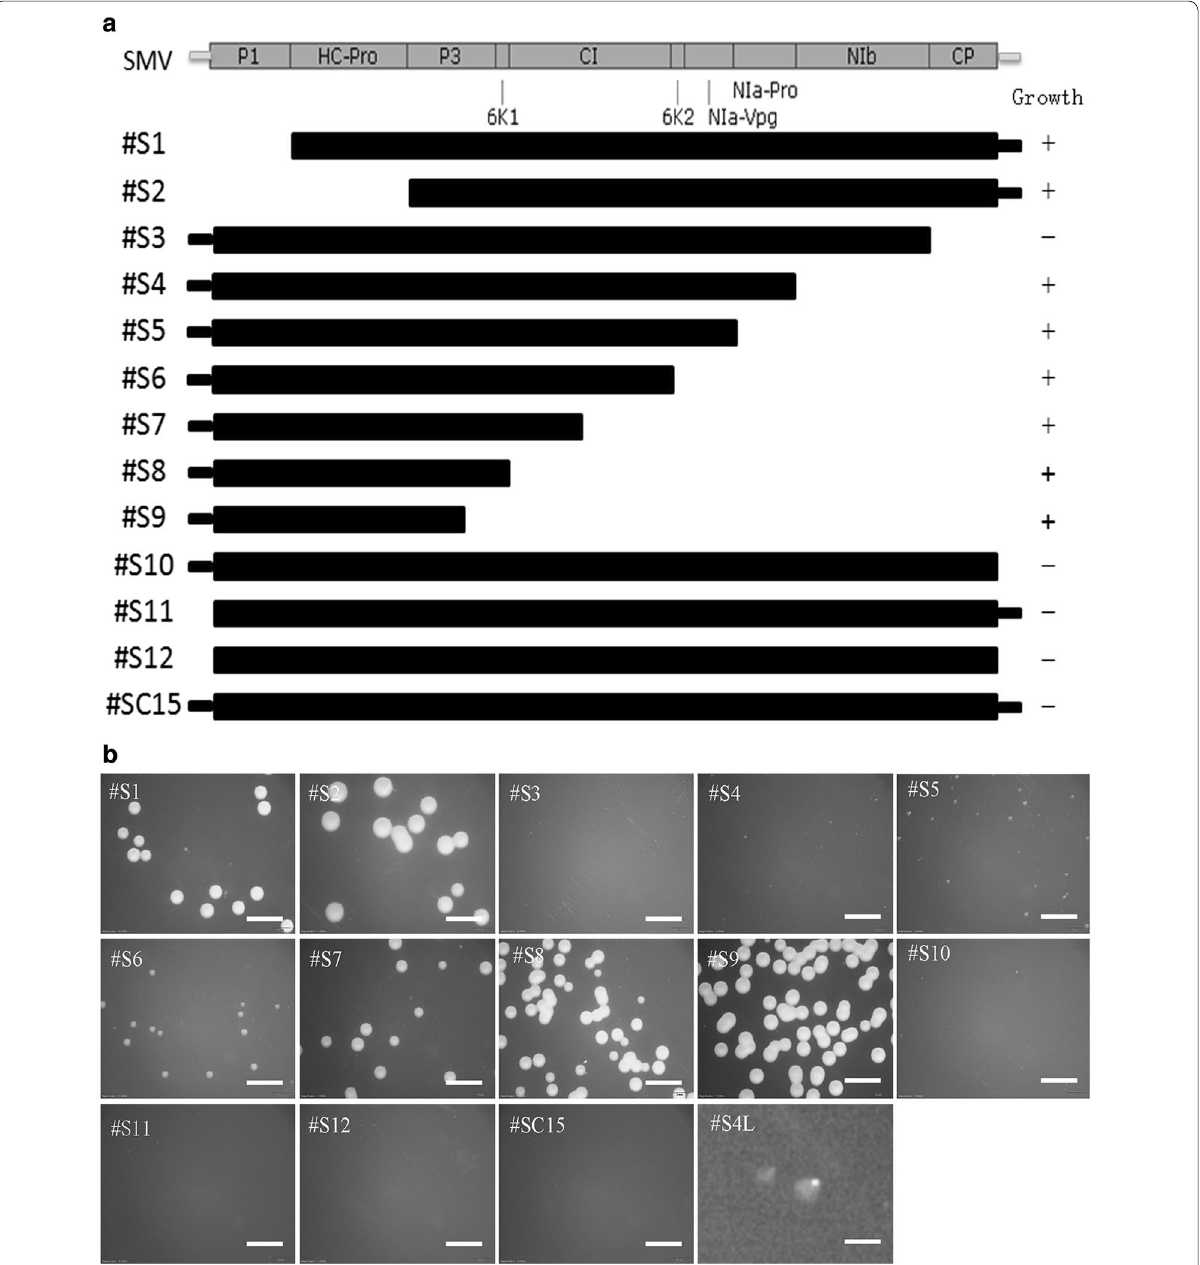
Fig. 4 Growth of Agrobacterium after transformation with the truncated virus clone of #SC15. a The truncated position of #SC15 and the growth of Agrobacterium after the transformation. “ ” indicates the colonies visible to the naked eye 2 days post-transformation, “ + Photographs of Agrobacterium growth after the transformation of each truncated clone; photograph #S4L is a close-up of photograph #S4; the scale bar in #S4L is 0.4 mm but in the other photographs it is 4